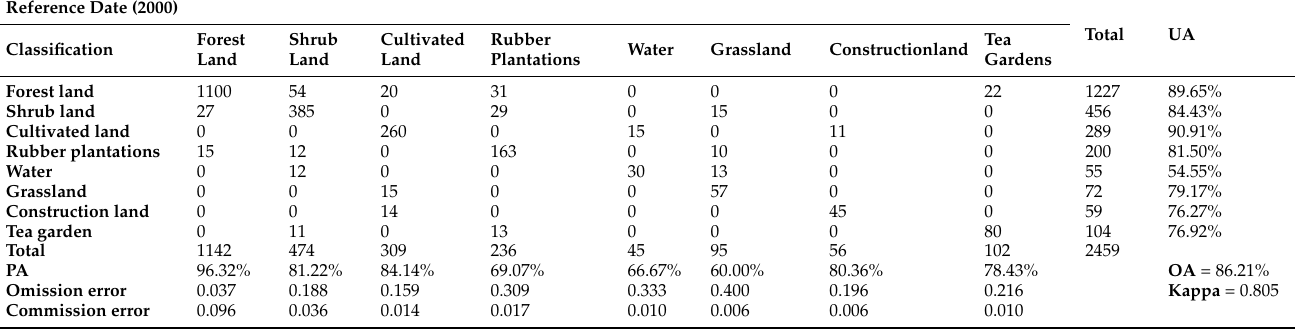
Table A2. The accuracies in 2000.